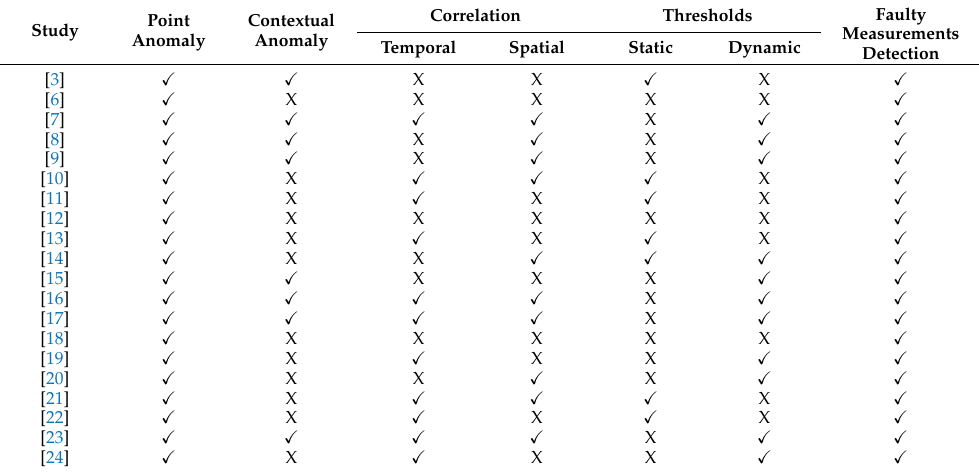
Table 1. Analysis of Existing